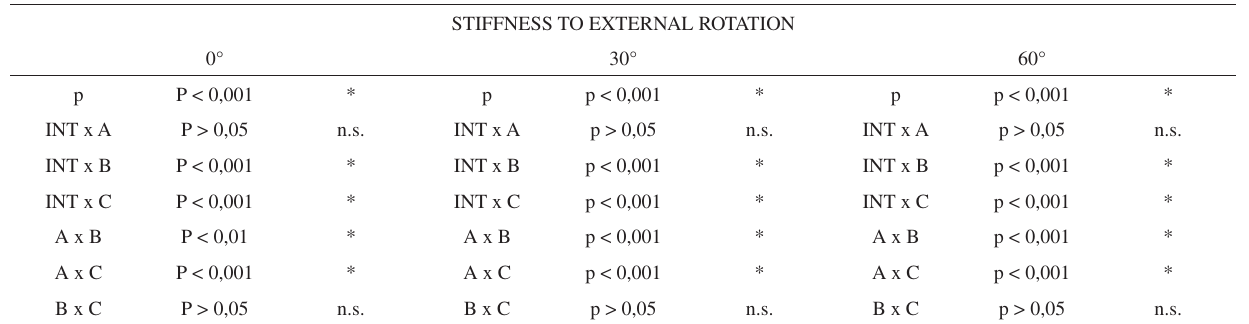
Table 6 - Comparative table and p values for the situations in external rotation testing to stiffness. STIFFNESS TO EXTERNAL